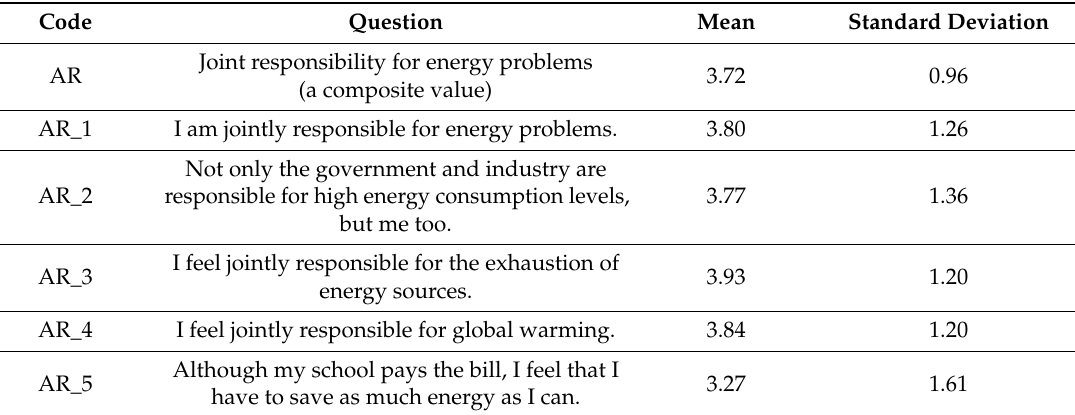
Table 11. Mean for ascription of responsibility (fully disagree (1) to fully agree (5)).